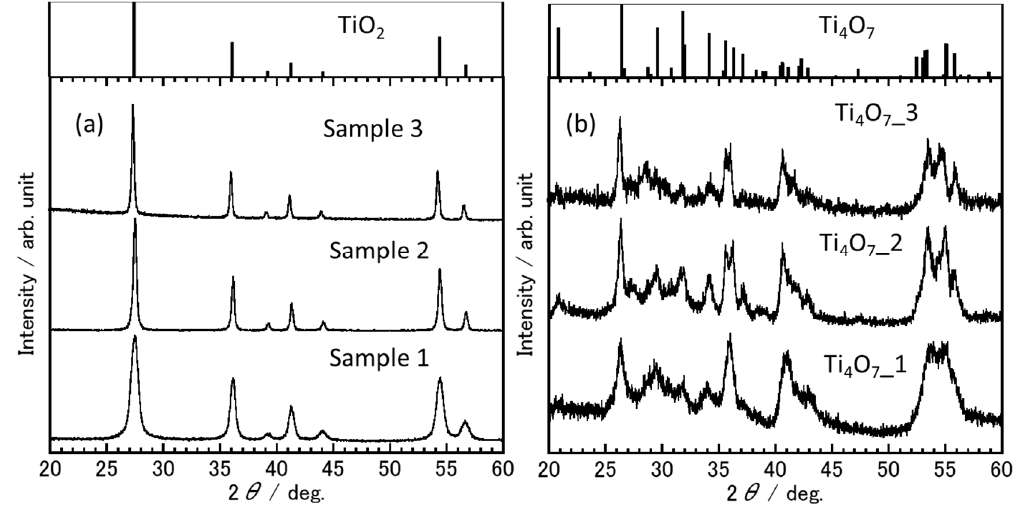
Figure 3. XRD patterns of (a) pristine TiO 2 (b) the samples after synthesis by microwave process. Ti 4 O 7 _1, Ti 4 O 7 _2 and Ti 4 O 7 _3 refer to particles after synthesis from Sample 1, Sample 2, and Sample 3, respectively.